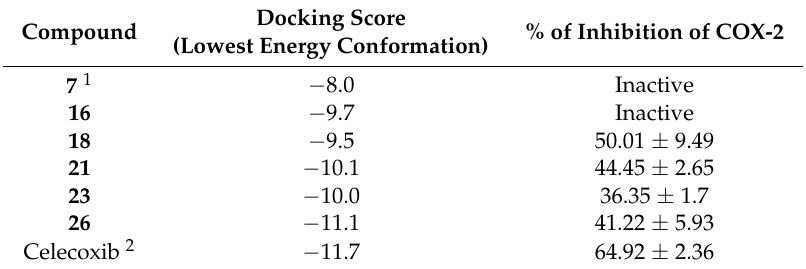
Table 3. Results for the in silico and in vitro evaluations against human COX-2 for selected compounds.